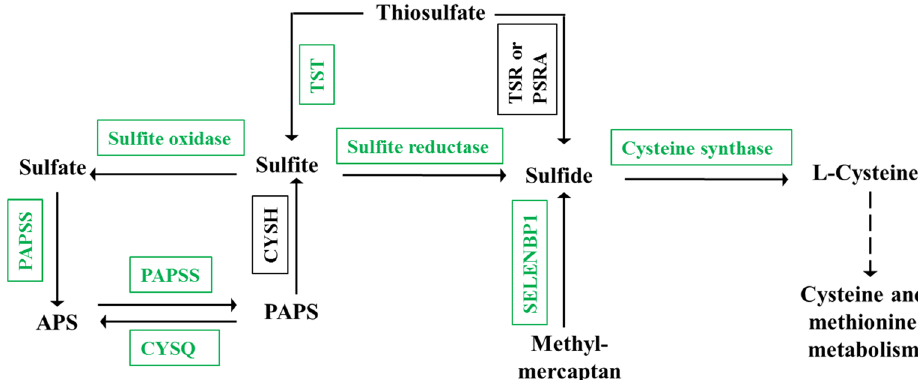
Figure 6. Khib regulated sulfur assimilation and metabolism. The Khib modified enzymes are indicated in green. APS: adenosine 5 ′ -phosphosulfate; PAPS: adenosine 3 ′ -phosphate 5 ′ -phosphosulfate; PAPSS: Sulfate adenylyltransferase; CYSH: phosphoadenosine phosphosulfate reductase; CYSQ: 3 ′ (2 ′ ),5 ′ -bisphosphate nucleotidase, SELENBP1:Selenium-binding protein 1, methanethiol oxidase; TST: thiosulfate/3- mercaptopyruvate sulfurtransferase; TSR: thiosulfate-dithioerythritol sulfurtransferase; PSRA: thiosulfate reductase/polysulfide reductase chain